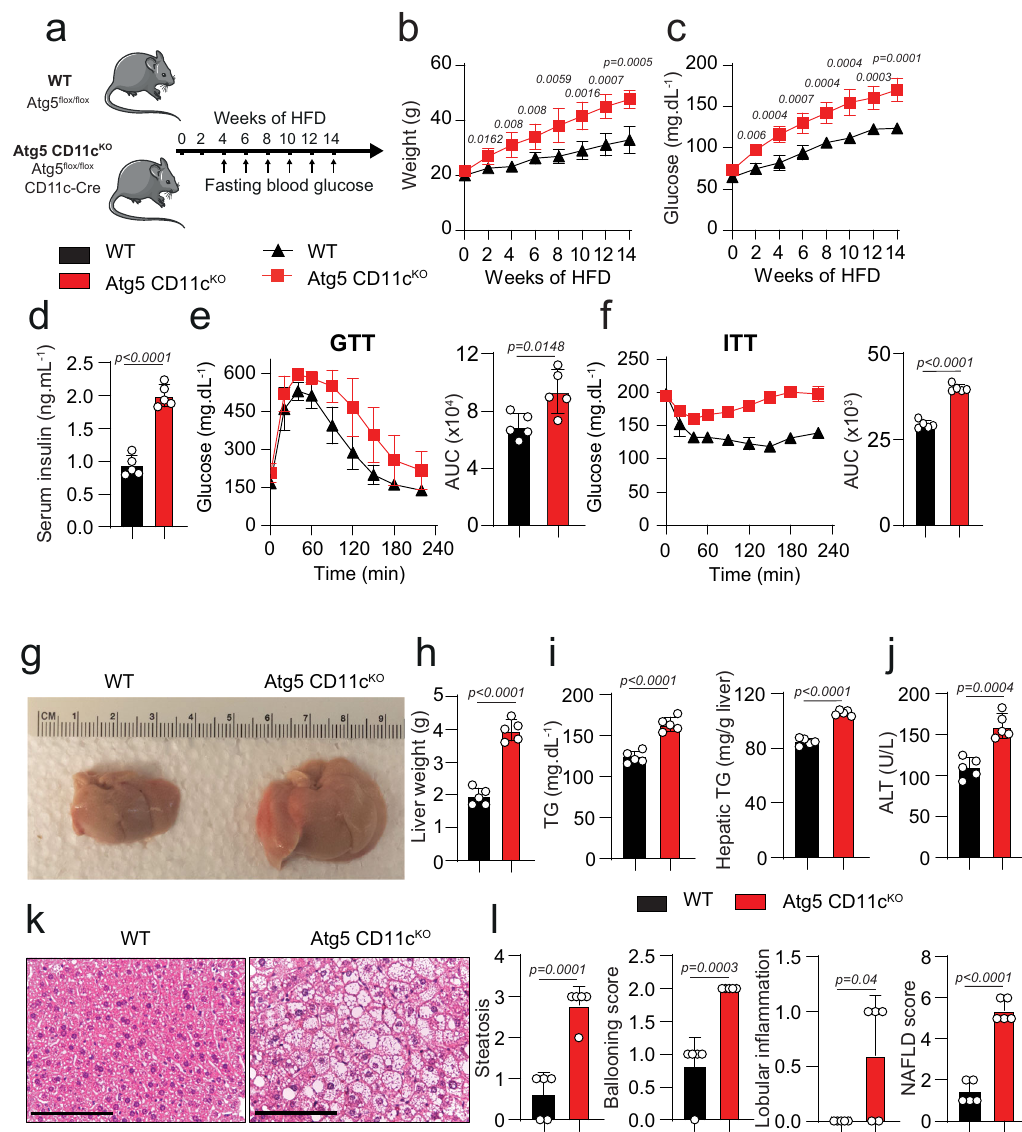
Fig. 4 Atg5 deletion in CD11c + cells induces insulin resistance in mice. a WT and Atg5 CD11c KO mice were fed HFD for 14 weeks according to the scheme, n = 6. b Total weight and c fasting blood glucose levels were measured every 2 weeks for 14 weeks. d Serum insulin concentrations were measured by ELISA after 24 weeks of HFD. Glucose tolerance test ( e ) and insulin tolerance test ( f ) were performed on WT and Atg5 CD11c KO mice fed HFD and treated for 14 weeks. The corresponding area under the curve was calculated for each group. g Photos of the dissected liver after perfusion. h Liver weights were measured after 14 weeks of HFD. i Serum (left) and hepatic (right) triglyceride levels was measured after 14 weeks of HFD. j Serum ALT was measured by colorimetric assay. k Representative hematoxylin and eosin-stained hepatic sections (×400), scale bars, 100 µ m. l Histology score for steatosis, hepatocyte ballooning, lobular in fl ammation, NAFLD Activity Score, and fi brosis was quanti fi ed. Error bars are the mean ± SD, two-tailed Student ’ s t test, n = 5 mice. Experiments were performed three times. Source data are provided as a Source Data fi le. Mouse image provided with permission from Servier Medical